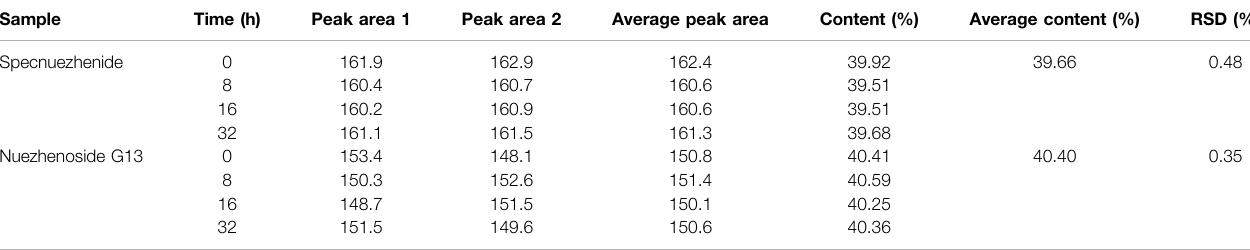
TABLE 6 | The stability test results of Specnuezhenide and Nuezhenoside G13. Sample